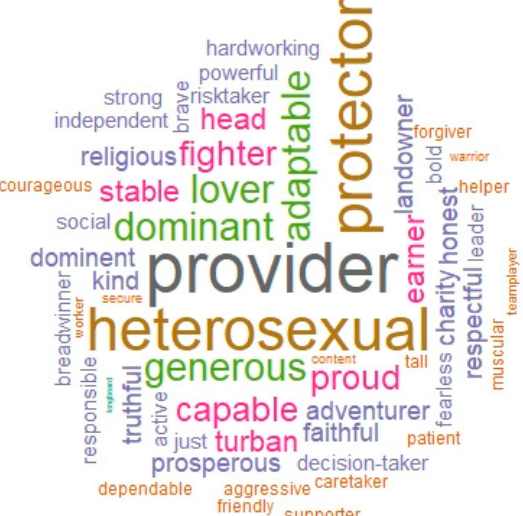
Figure 1. The expected elements of masculinity in the Sikh community in Italy and Spain. Source: Own elaboration.